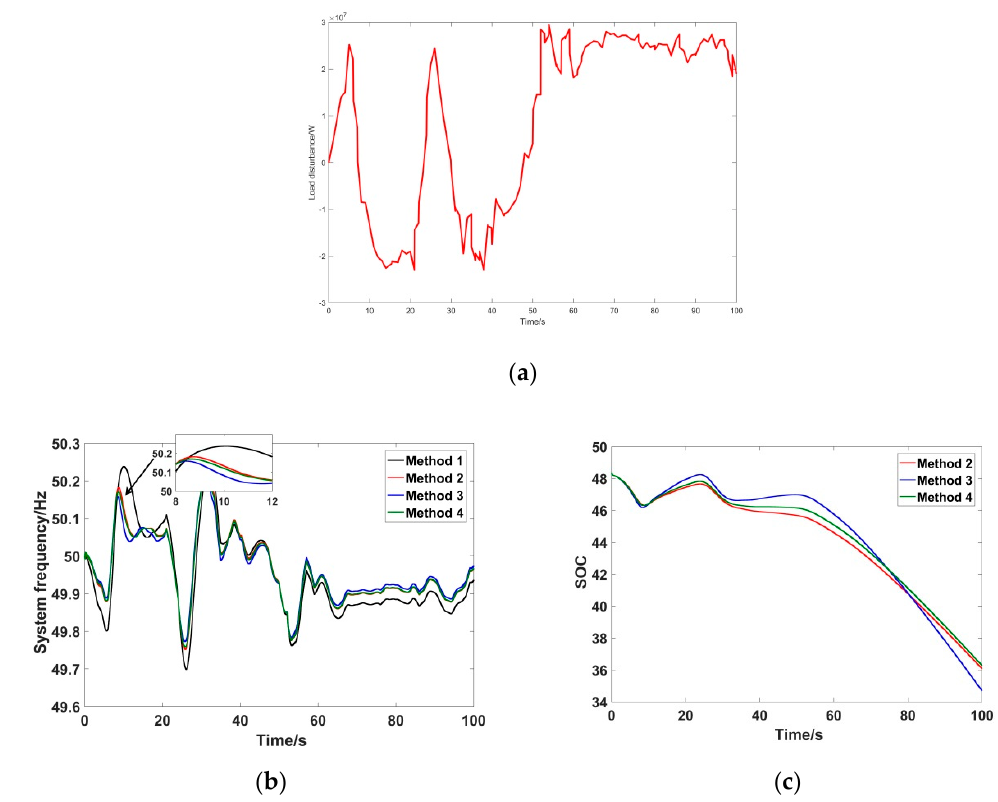
Figure 22. Results of continuous load disturbance (Load C). ( a ) Continuous load disturbance curve. ( b ) System frequency curves under continuous load disturbance. ( c ) SOC curves of the energy storage system.